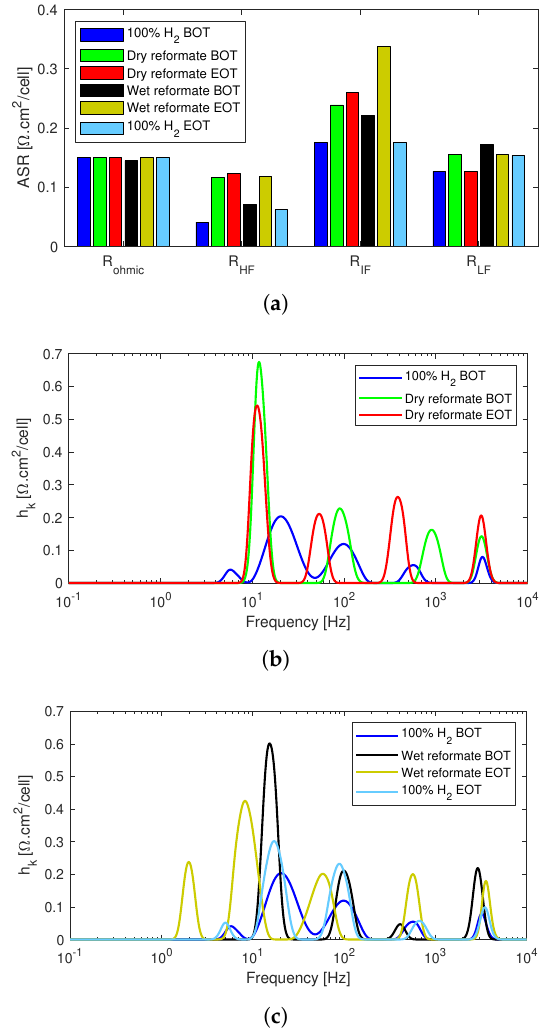
Figure 7. EIS data analysis of the poisoning effects of reformate impurities in the anode feed of the post-doped MEA-based HT-PEMFC stack. ( a ) Equivalent circuit model fitted resistance data. ( b ) DRT analysis of dry reformate. ( c ) DRT analysis of wet